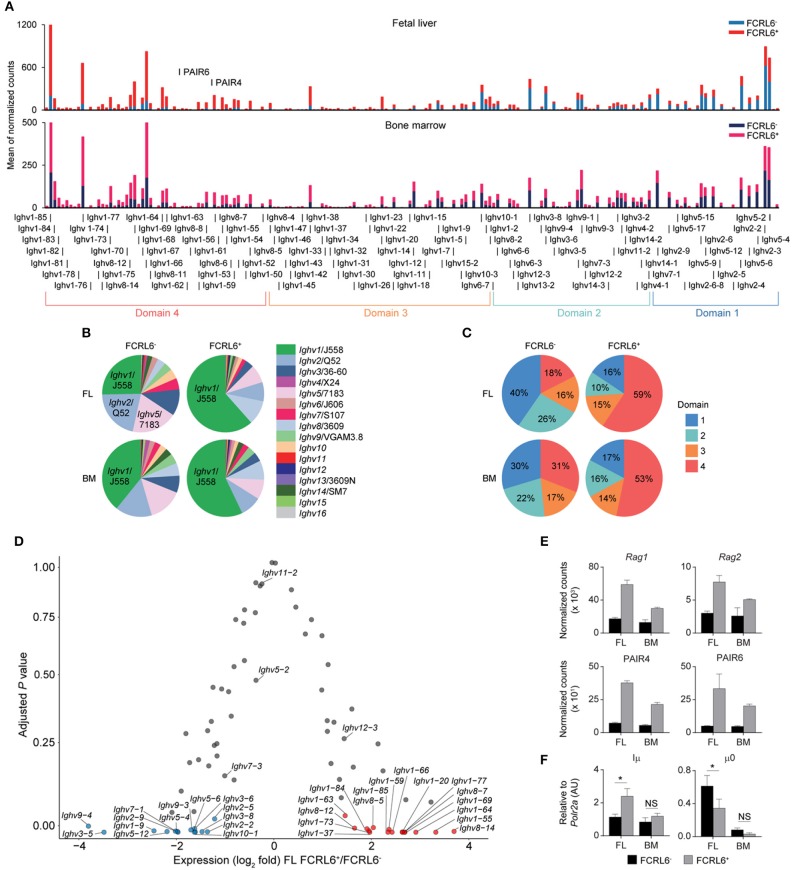
FCRL6 discriminates pro B cells with divergent Ighv locus accessibility. (A) Individual segment usage across the Ighv locus based on the means of normalized counts from duplicate FL and adult BM pro B cell subsets. The locus is segregated into four domains based on Choi et al. (68). The PAIR4 (ENSMUSG00000104373/Gm37511) and PAIR6 (ENSMUSG00000104373/Gm37511-Gm30996) ncRNA elements are indicated in domain 4. (B) Frequency of Ighv family usage among the four subsets based on the summation of the means of normalized counts from total Ighv segments of each subfamily. (C) Frequency of domain usage based on the summation of the means of normalized counts from grouped Ighv locus genes segregated as indicated in (A). (D) Volcano plot detailing RNA-seq analysis of Ighv genes from sorted FL FCRL6+ and FCRL6− pro B cells. Results are presented as the difference in fold expression (log2 transformed values) of FCRL6+ relative to FCRL6− pro B cells and plotted against adjusted P-values. (E) RNA-seq analysis of coding and non-coding genes relevant to V(D)J rearrangement and locus contraction from the four FL and BM FCRL6+ and FCRL6− pro B cell subsets. Note Rag2 is among FL DEGs, while the other DEGs overlap between the FL and BM. (F) RQ-PCR of non-coding transcripts involved in initiating locus recombination relative to Polr2a. Small horizontal lines (E,F) indicate s.e.m. *P < 0.05 as determined by paired Student's t-test. Data are from four independent sorts and two per cell type as in Figures 3A–E and three independent sorts per subset performed in duplicate (F).